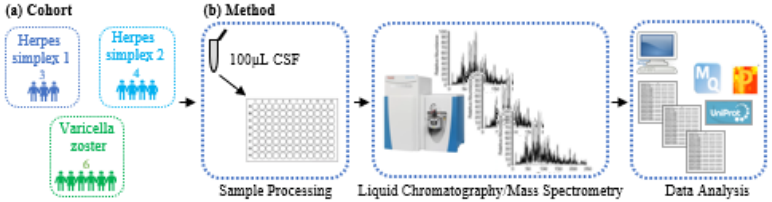
Figure 1. Schematic of the CSF proteomics platform including LC–MS/MS acquisition and data anal- ysis, which was used to process one hundred µL of CSF from thirteen herpes infected patients. ( a ) Cohort schematic comparing three HSV-1-, four HSV-2-, and six VZV-infected patients. ( b ) Method schematic of our in-house-developed high throughput CSF proteomics